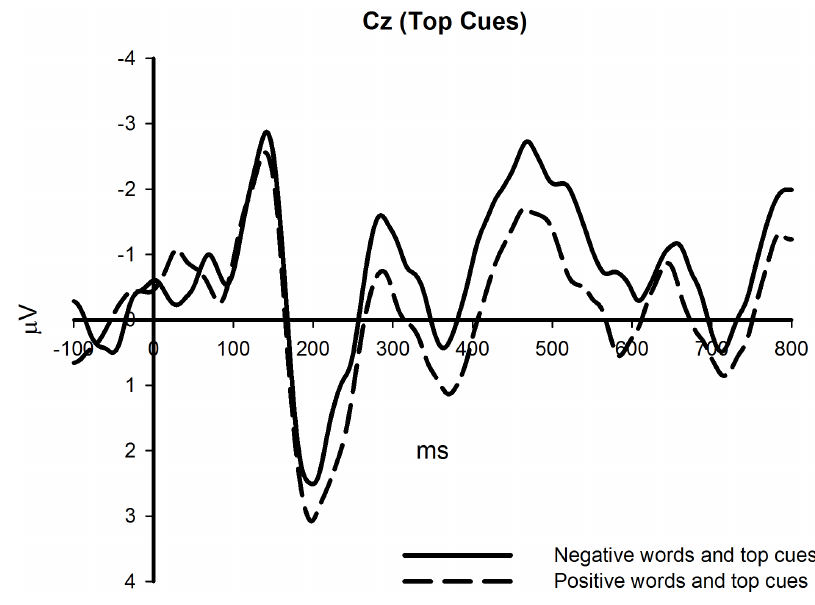
Figure 3. The effects of different affective words on top cues (Cz site).